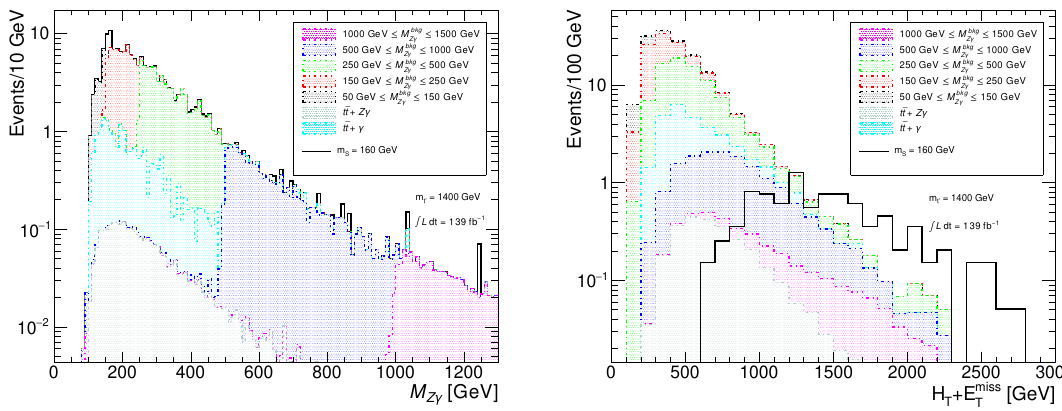
Figure 8 . Distributions of M Z(cid:13) and H T + E miss